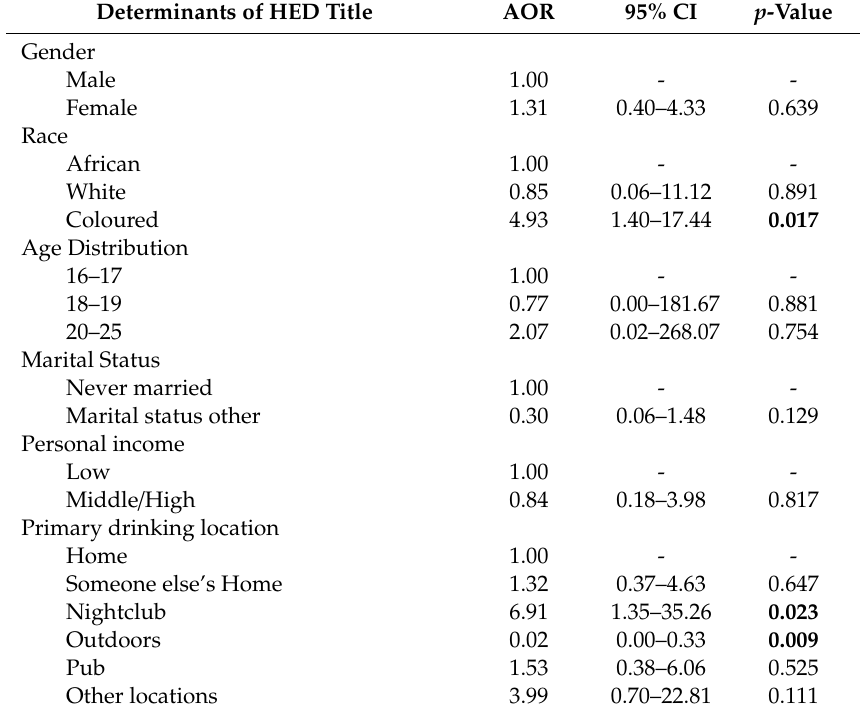
Table 3. Multiple logistic regression and determinants of heavy episodic drinking among 16–25 year old